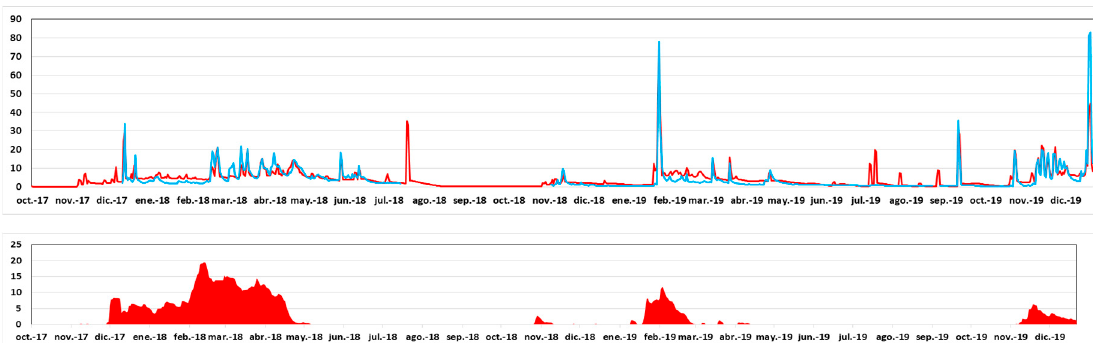
Figure 9. Upper level. Real (blue) and calculated (red) daily flow rates in A203. Lower level. Snow water equivalent in the catchment for the validation period.